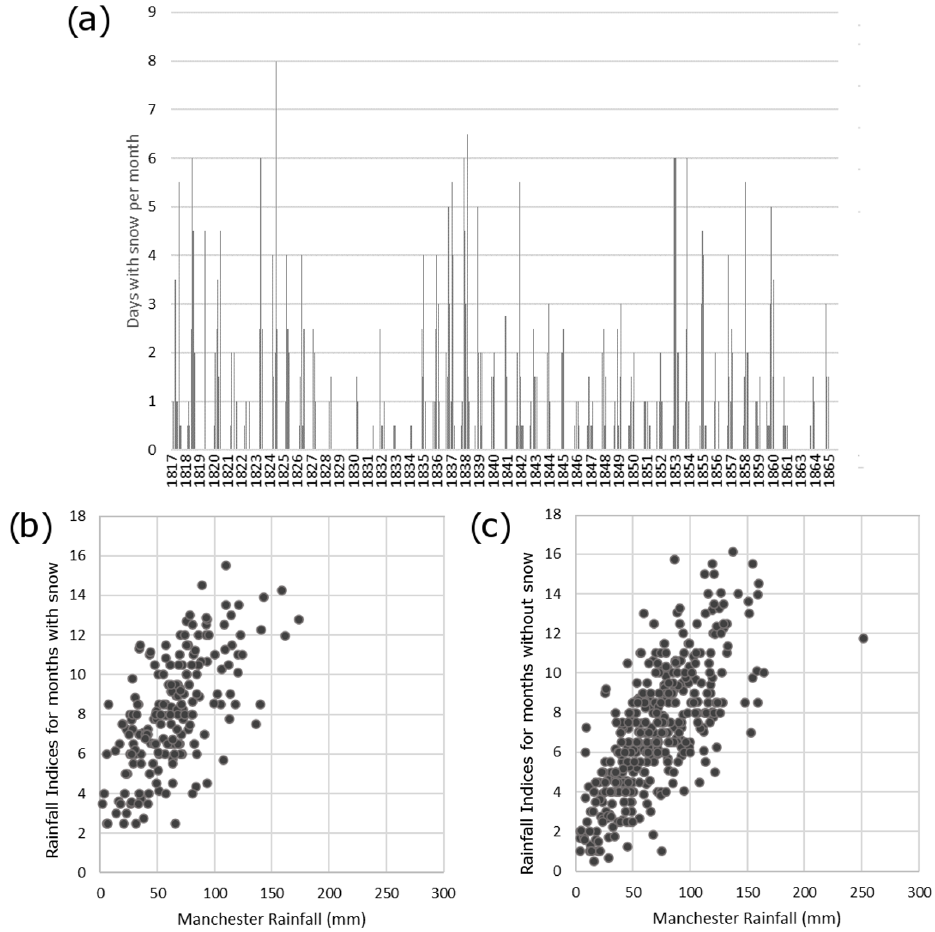
Figure 7. (a) Days of snow per month at Trentham (note data for 1862 are missing) and precipitation index for months with (b) and without (c) snow, plotted against Manchester rainfall. For the months with snow r = 0 . 63; for months without snow r = 0 . 71 (for all correlations p = < 0 .